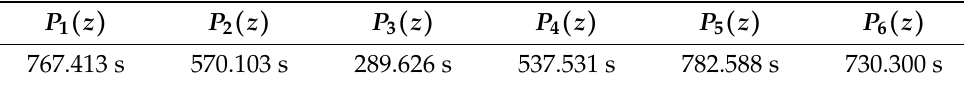
Table 2. Execution time in seconds required by PM 10 for each P i ( z ) , i = 1,2, . . .